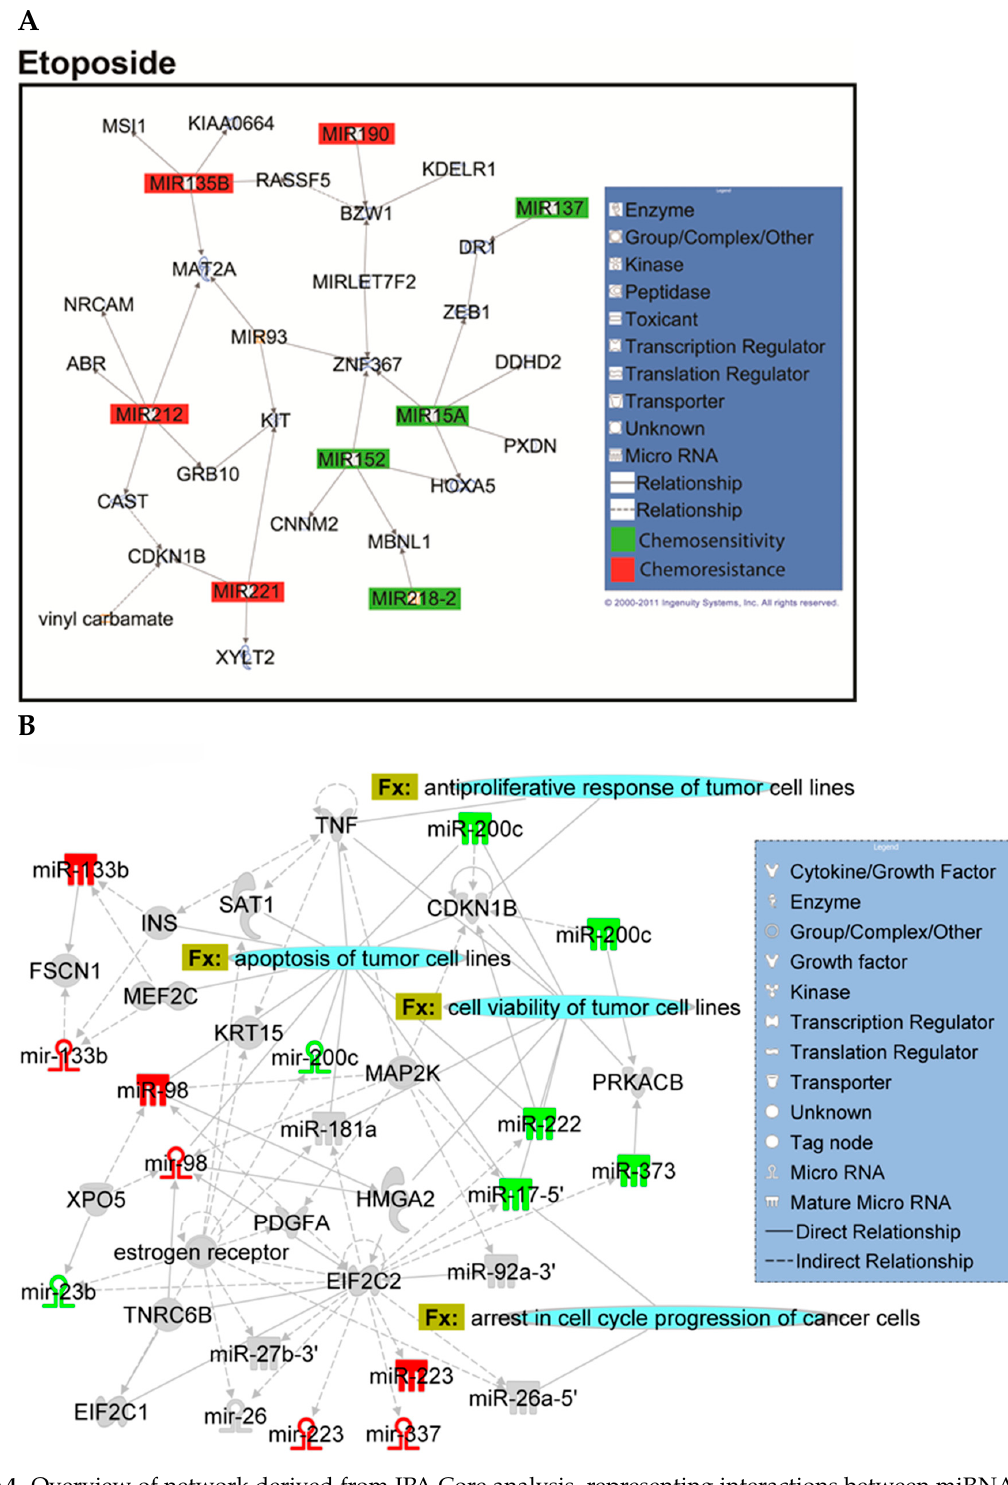
Figure A4. Overview of network derived from IPA Core analysis, representing interactions between miRNAs found to be chemopredictive for etoposide and genes relevant to the significant functions and diseases listed in Tables 3 and 4. ( A ) miRNAs and their mRNA target genes. ( B ) Involvement of miRNAs in pathways, functions, and diseases. Canonical pathways (CP:) and functions and diseases (Fx:) as defined by IPA are overlaid to highlight the interconnectedness of the set with molecular processes relevant to chemoresponse. Predictive miRNAs whose expression was positively associated with survival are shown in green, and those whose expression was negatively associated are shown in red.